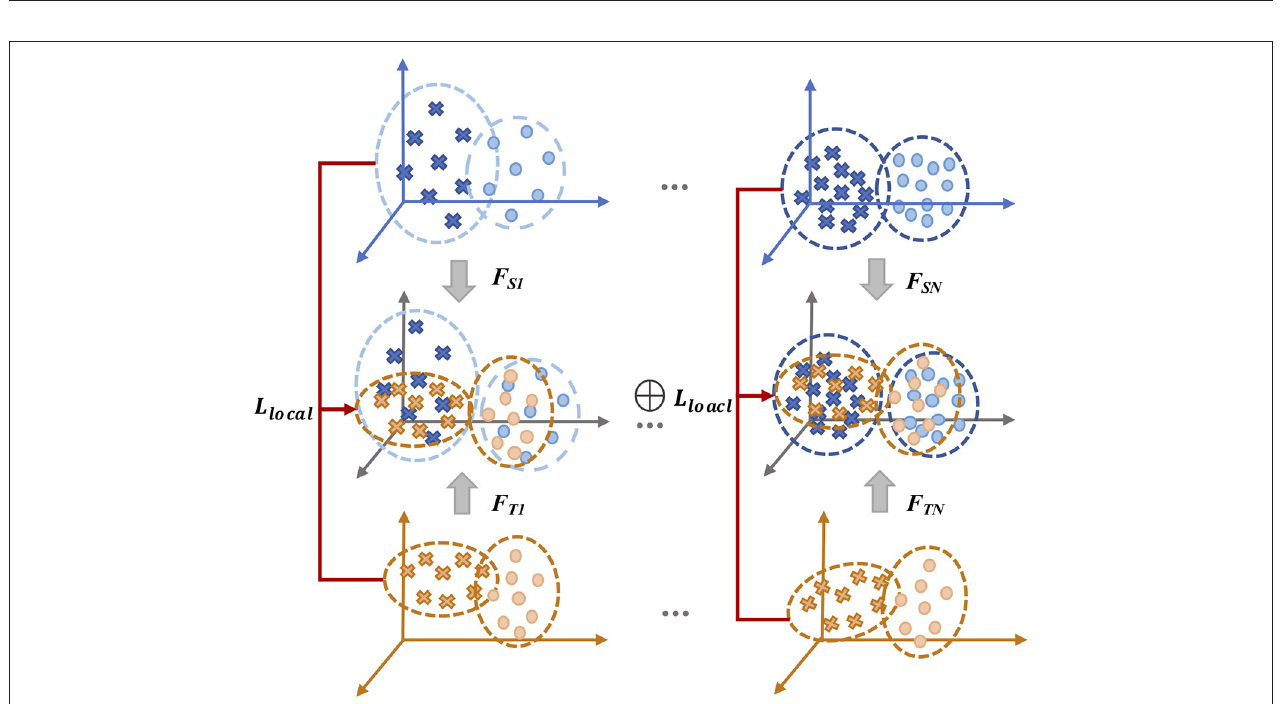
FIGURE 5 | The framework of Local Label-based Maximum Mean Discrepancy